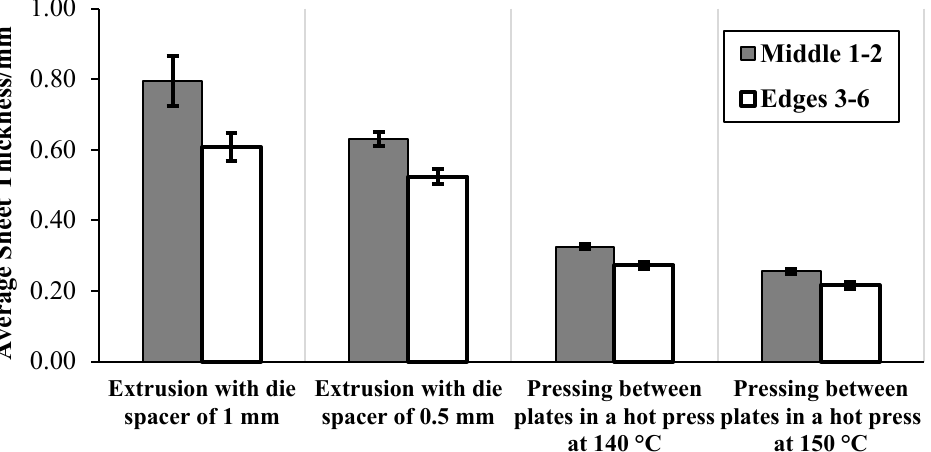
Figure 4. Graph displaying the average thicknesses of the sheets along the extrusion axis 1–2 (middle 1–2) and at the edges 3–6.